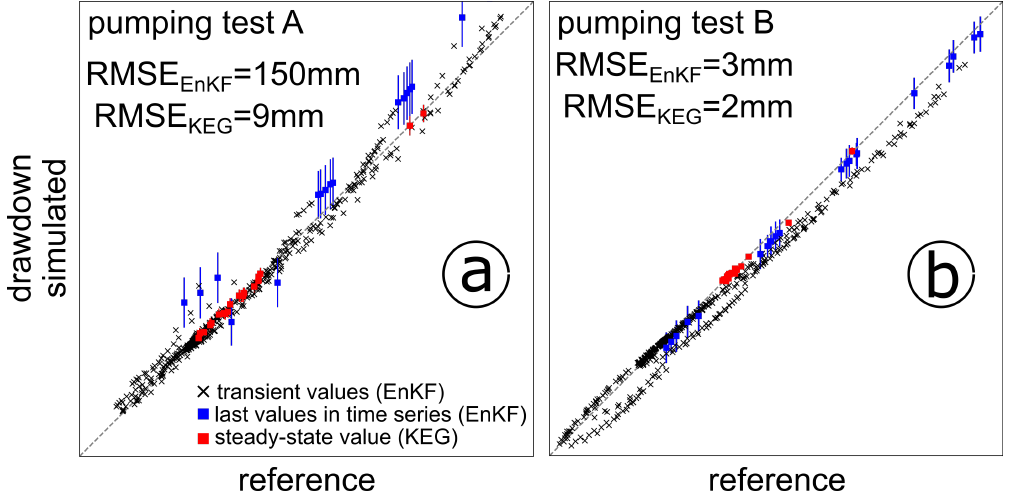
Figure 7. Calibration plot for the assimilated transient drawdown of pumping tests A ( a ) and B ( b ) used with the EnKF (black crosses), and the steady-state drawdown for the last update iteration with the KEG. Blue squares correspond to the last assimilation time-step with the EnKF. RMSE: root mean square errors. Red and blue bars represent the ensemble spread of drawdown